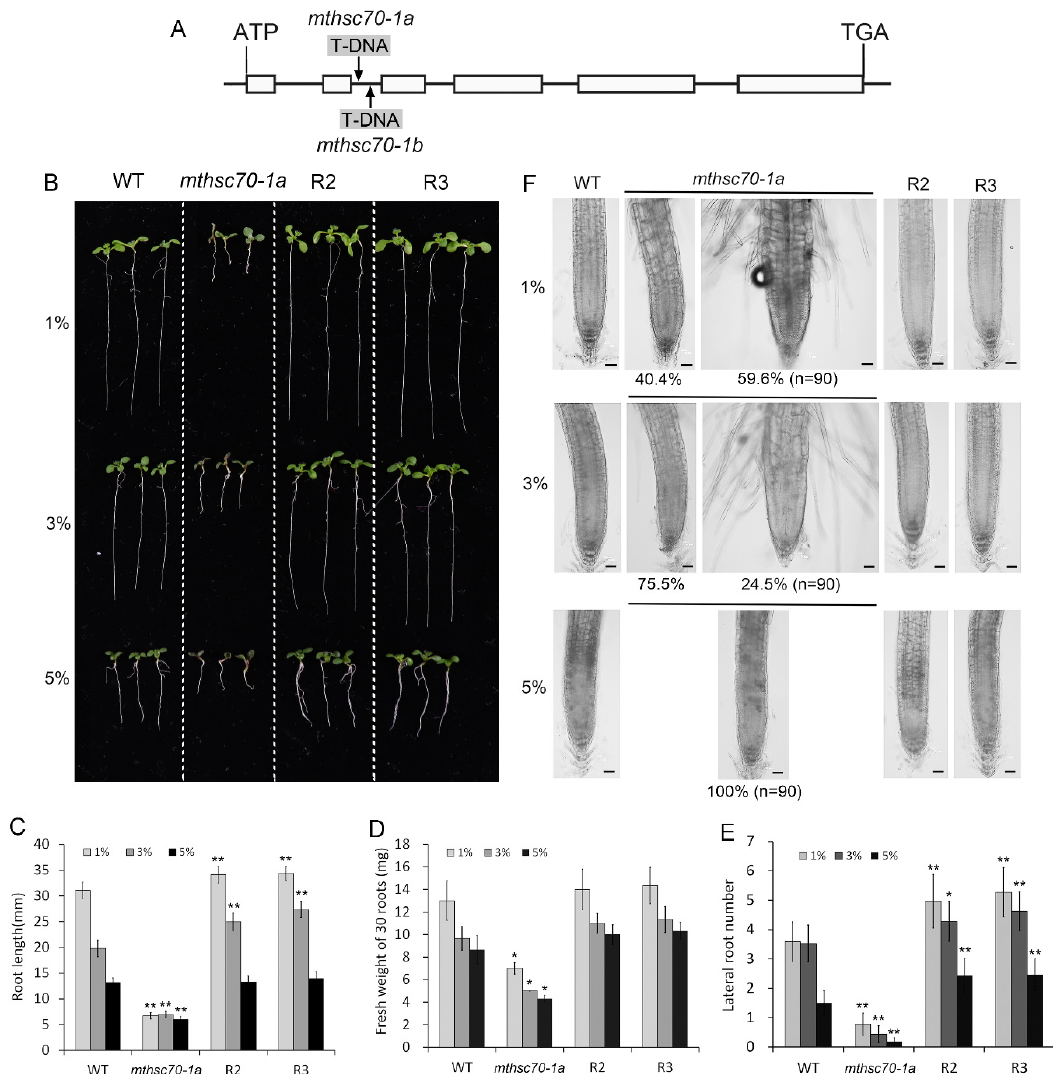
Figure 1. The effects of glucose on root growth and development in wild type, mthsc70-1a , and two complementary mthsc70-1a lines. ( A ) Intron/exon organization of the mtHSC70-1 CDS and T-DNA insertion locations. Boxes, exons; lines, introns; arrows, T-DNA insertion positions. ( B ) Representative seedlings after 10 days of growth in 0.5 × MS medium supplemented with 1%, 3% or 5%